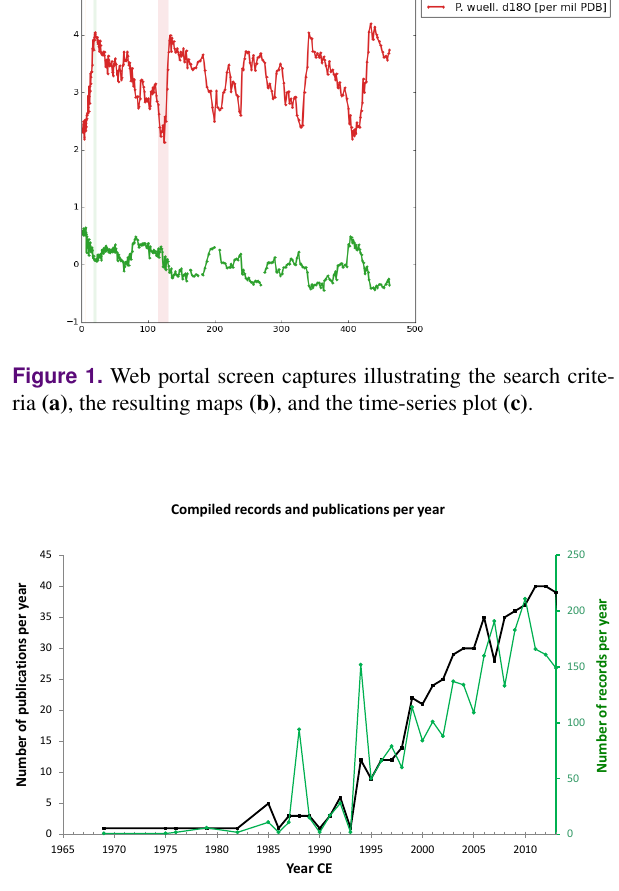
Figure 2. Number of publications and records in the database ver- sus year of publication.